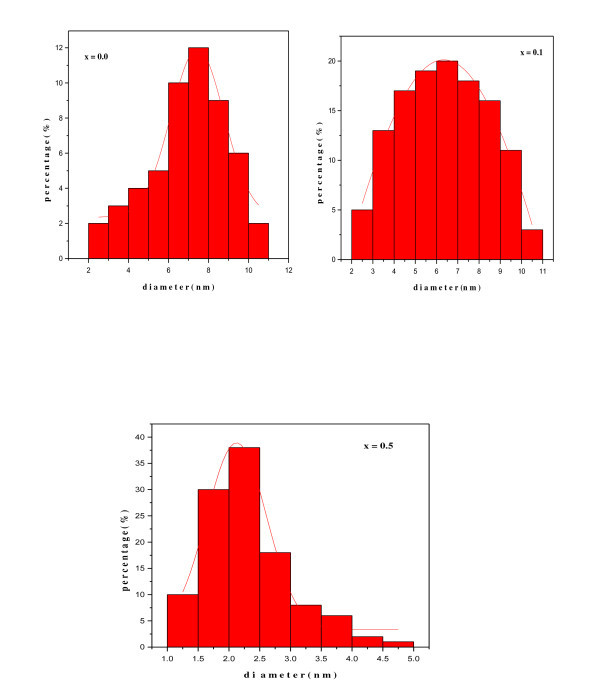
Typical histograms showing size distribution of Ni0.2Cd0.3Fe2.5 - xAlxO4 (0.0 ≤ x ≤ 0.5) ferrite nanoparticles.